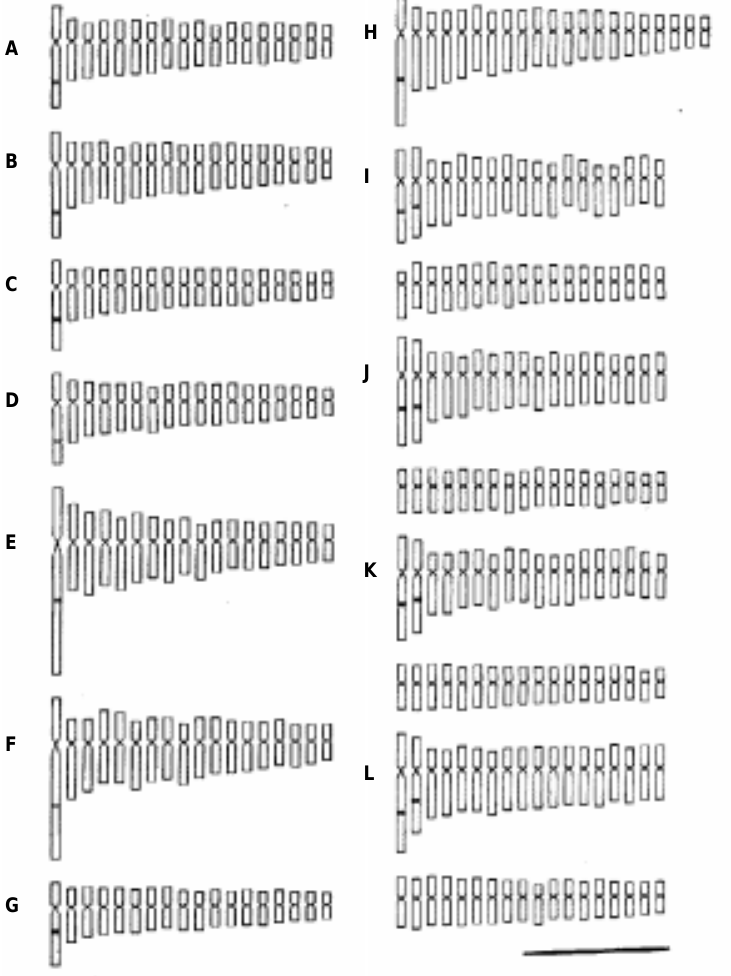
Figure 3 - Comparative idiograms of 12 cytotypes of Mikania micrantha . A. Piracicaba, B. Petrópolis, C. Praia Grande, D. Alfredo Guedes, E. Estrela do Norte, F. Praia de Ipanema, G. Campinas, H. Joinville, I. Foz do Iguaçu, J. Guaíba, K. Tamarana, L. Apucarana. Bar = 4 m m. The B-chromosomes are not represented.